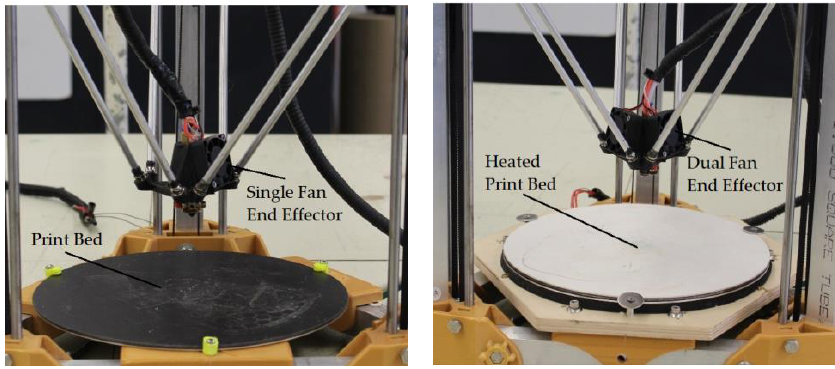
Figure 4. Comparison of the base Kijenzi design ( left ) and upgraded features for higher temperature materials ( right ).